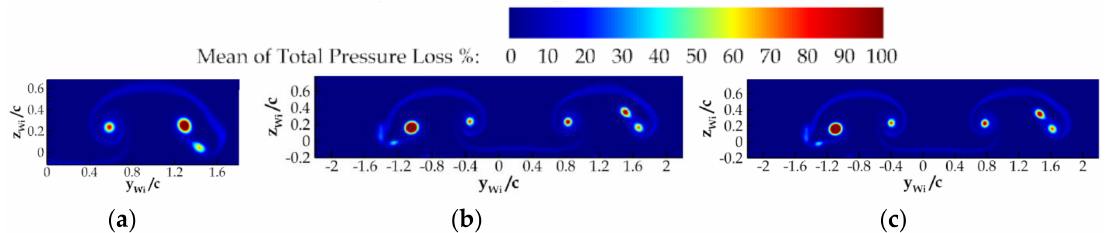
Figure 22. Contours showing the mean of the total pressure loss at x Wi /c = 2.545; the contour range has been capped to a maximum of 100% to improve the visibility of the wake. ( a ) Straight-line condition; ( b ) Cornering condition; ( c ) Fixed yaw